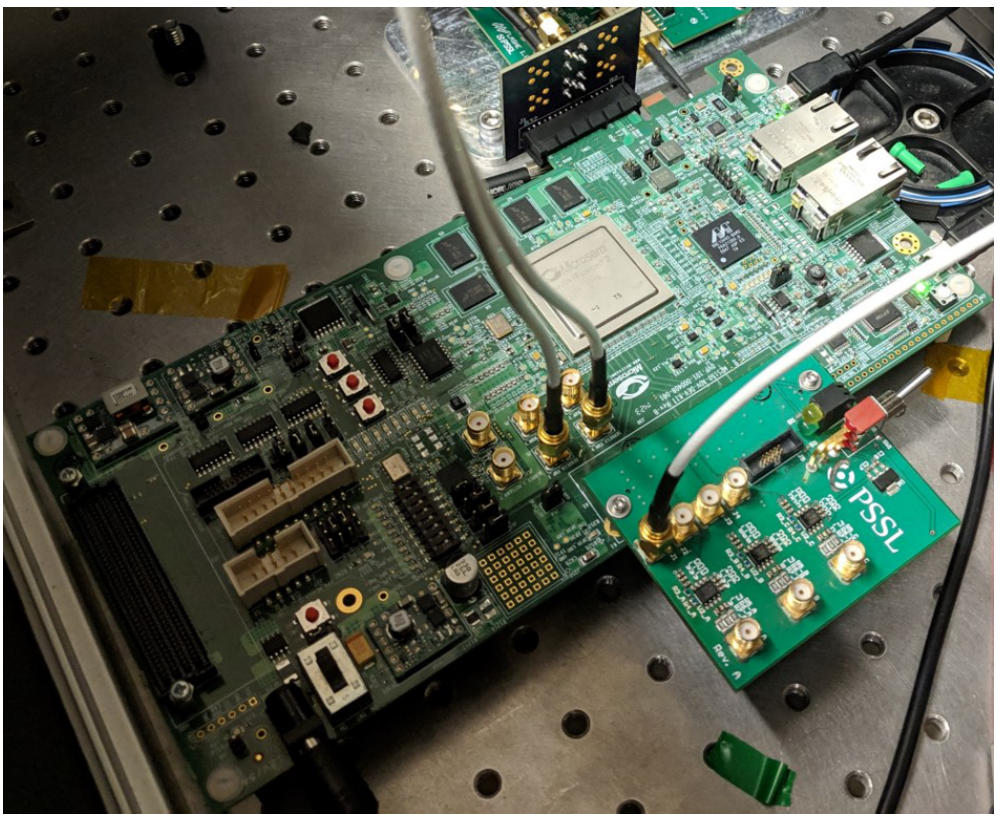
Figure 3. Here is the FPGA based modulator for MOCT on its development board. It is responsible for sending data to the seed laser in order to be transmitted to the